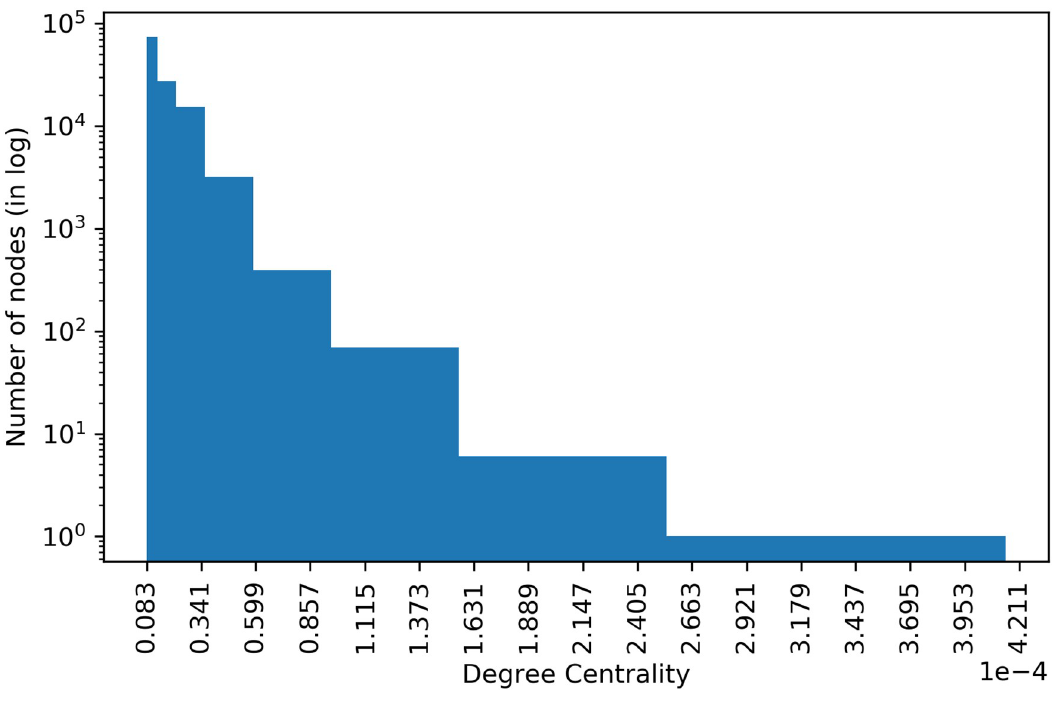
Fig 5. Distribution of degree